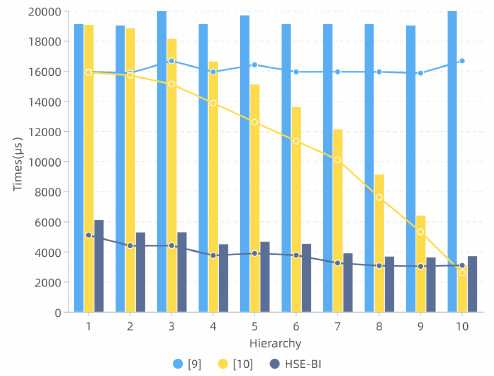
Figure 5. The Relationship between Hierarchy and Search